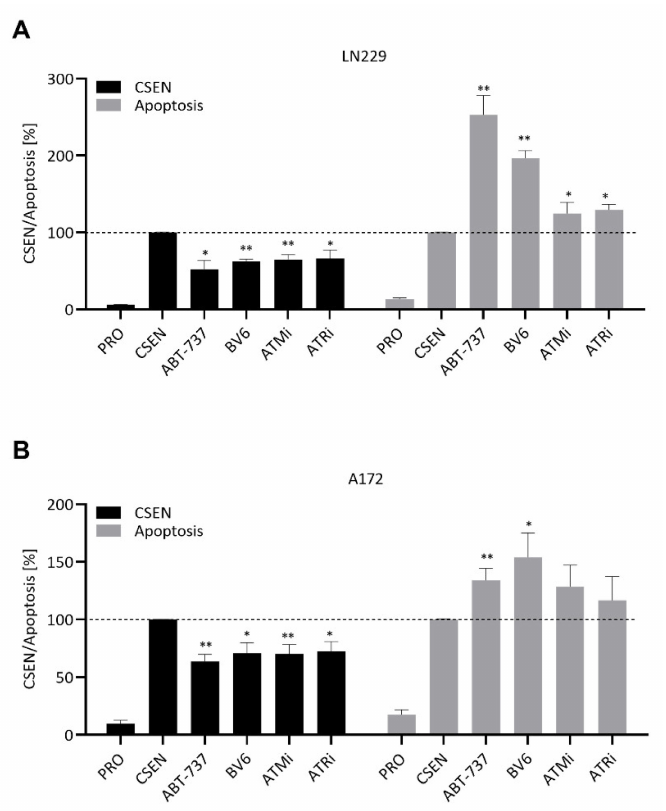
Figure 5. Identification of diverse compounds with senolytic activity. Proliferating (PRO) and senescent (CSEN) LN229 and A172 cells were treated with several substances to test their senolytic capacity. ABT-737 served as positive control. Inhibition of cIAP1/XIAP (BV6), ATM and ATR reduced senescence levels in LN229 ( A ) and A172 ( B ) cells. Apoptosis was concomitantly increased for all substance in LN229 ( A ), while only inhibition of cIAP1/XIAP had such effect in A172s cells ( B ). Data represent mean of >3 independent experiments ± SEM. * p < 0.05, ** p <